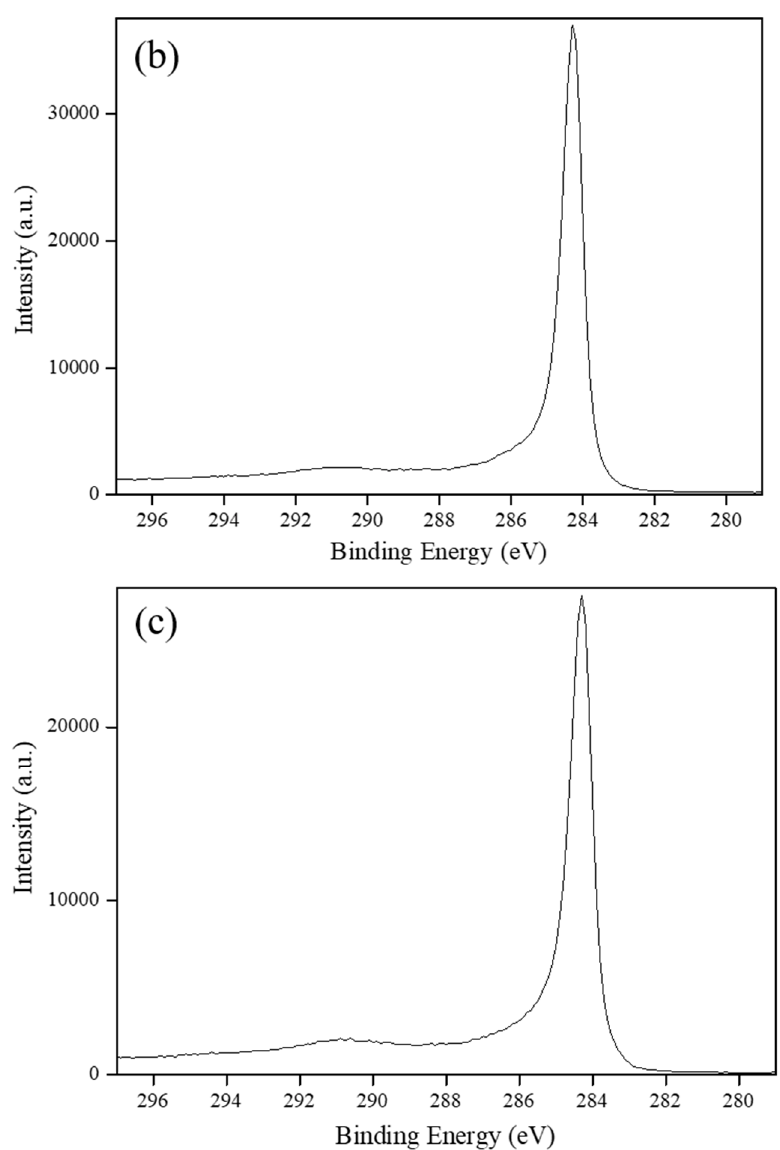
Figure 2. XPS spectra of: ( a ) VulcanXC72, ( b ) Graphene and ( c ) MWCNTs.